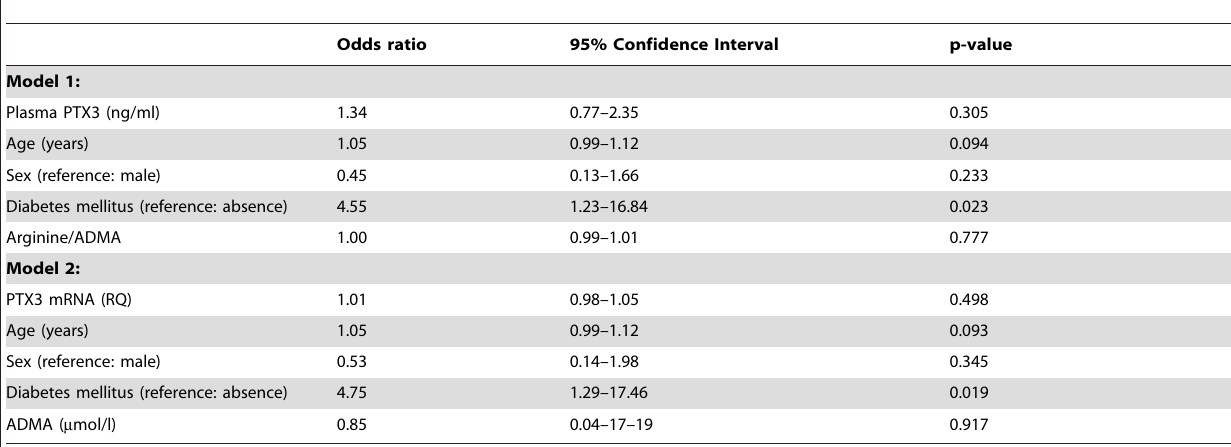
Table 4. Multivariate logistic regression models investigating predictors of CVD (presence/absence) in 56 patients with CKD stage 5, including plasma PTX3 concentrations and Arginine/ADMA ratio (Model 1; pseudo R 2 =0.20, p =0.0125) or adipose tissue PTX3 mRNA and ADMA (Model 2; pseudo R 2 =0.16, p =0.0547) as